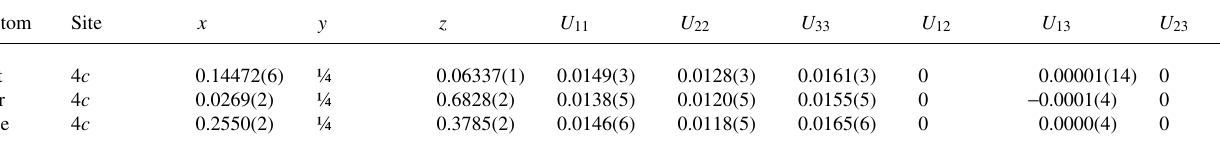
Table 4. Atomic coordinates and displacement parameters (in Å 2 ) .